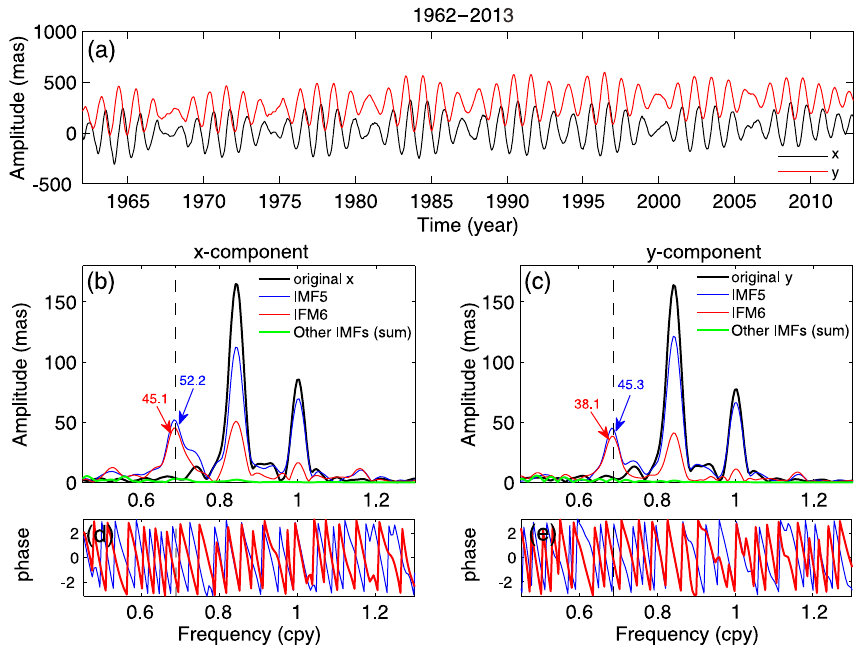
Figure 1. The x - (black) and y -components (red) of the 1962–2013 PM series (a) and their corresponding Fourier amplitude spectra (original spectra, denoted by the black curves in b and c ). (b) x -component; (c) y -component. The spectra for IMF5 and IMF6 after applying EEMD to x - and y -components are indicated by blue and red curves, and their corresponding phases (based on the discrete Fourier transform) are shown in (d) and (e) , respectively. The spectra (residual spectra) for other IMFs (sum) of x - and y -components are denoted by the green curves.